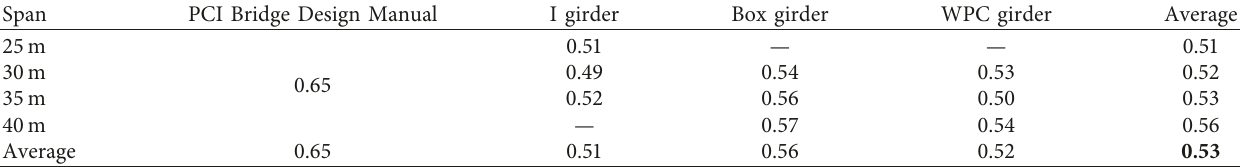
Table 4: Ratio of noncomposite to composite moments of inertia by girder type and span. Span